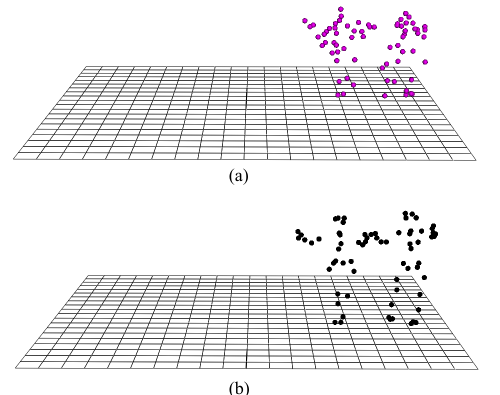
Figure 12. A representation of the decompressed data ( a ) relative to the original skeletal data ( b ), for the same time frame as for Syrtos (2b) dance sequence.